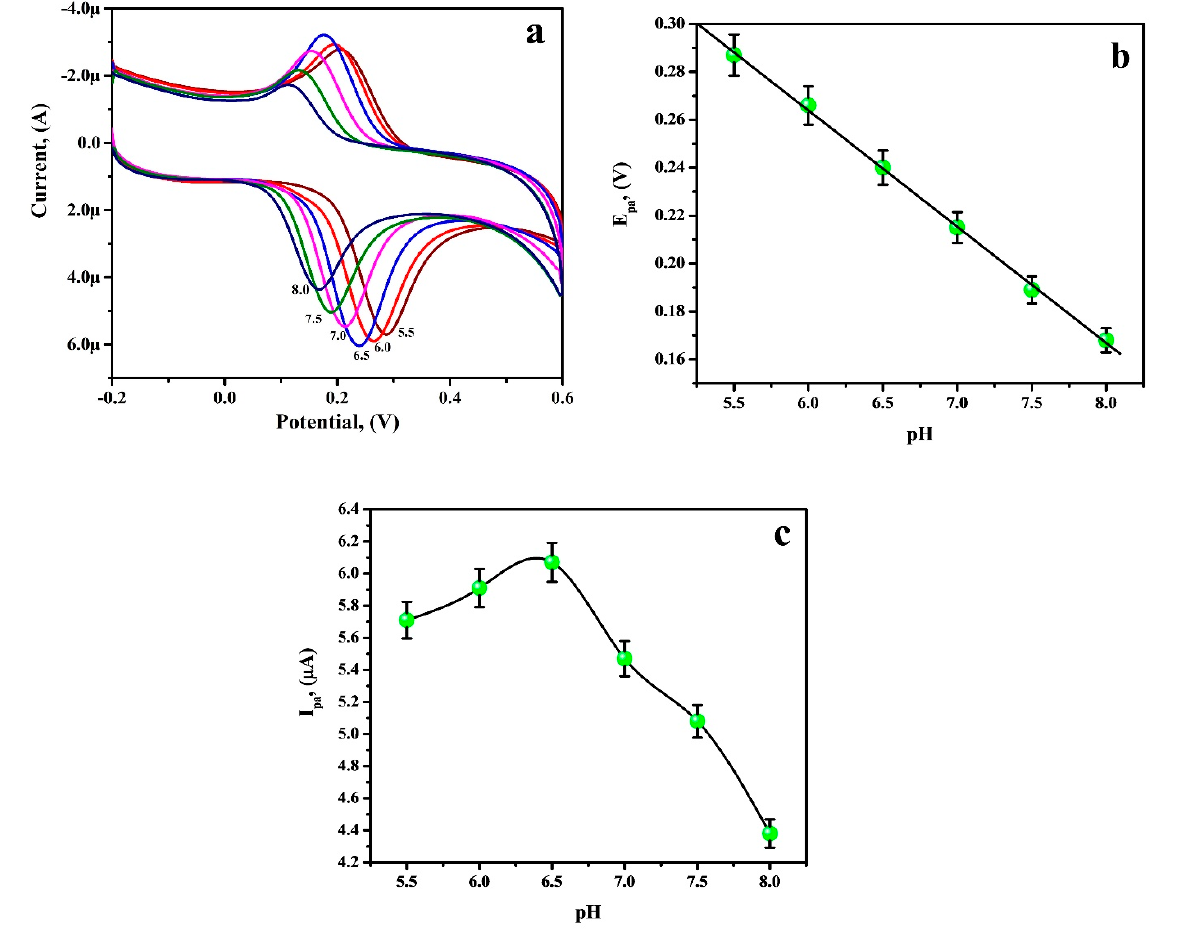
Figure 5. ( a ) CV response of 0.1 mM RU at PGAMGPE in 0.2 M PB of pH ranging from 5.5 to 8.0. ( b ) Plot of E pa versus Ph. ( c ) Plot of I pa versus pH of solution.